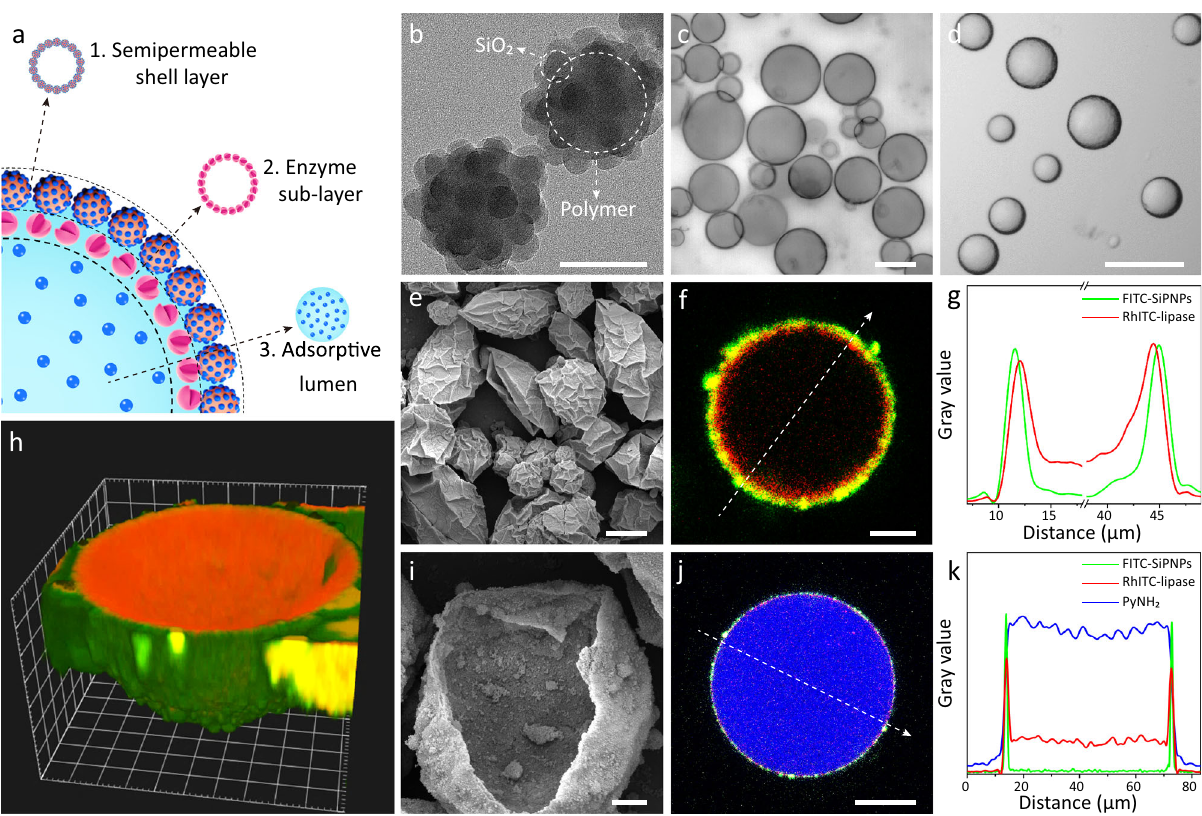
Fig. 2 Structural and morphological characterization of the three-tiered colloidosomes. a Schematic illustration of a three-tiered colloidosome consisting of a semi-permeable crosslinked SiPNP layer, a catalytic sub-layer of lipase, and an aqueous lumen with adsorptive SiO 2 nanoparticles. b Transmission electron microscopy image of SiPNPs showing the raspberry-like shape of SiO 2 -polymer hybrid nanoparticles. Scale bar: 100 nm. c , d Optical micrographs of the lipase-loaded non-crosslinked colloidosomes ( c ) and the crosslinked colloidosomes ( d ). Scale bars: 20 μ m. e SEM image of the crosslinked colloidosomes showing the wrinkled hybrid shells. Scale bar: 20 μ m. f – h CLSM image ( f ), the corresponding fl uorescence intensity pro fi les ( g ), and 3D- reconstructed CLSM image ( h ) were used to identify the SiPNP shell (green fl uorescence) and the lipase layer (red fl uorescence) of the crosslinked colloidosomes. Scale bar: 20 μ m. Grid width in h : 4 μ m. i SEM micrograph of a cracked colloidosome showing a thick hybrid silica-polymer layer and small SiO 2 nanoparticles in the interior phase. Scale bar: 2 μ m. j , k CLSM image ( j ) and the corresponding fl uorescence intensity pro fi les ( k ) showing the uptake of PyNH 2 by the crosslinked colloidosomes in isooctanol. Scale bar: 20 μ